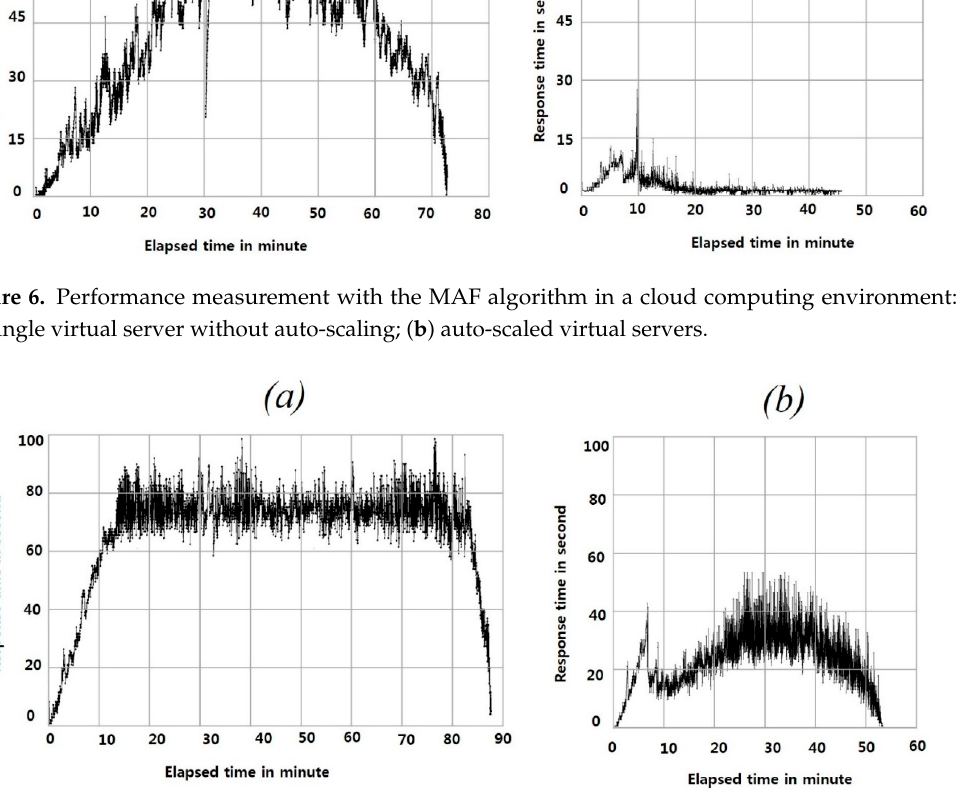
Figure 7. Performance measurement with the NDVI algorithm in a cloud computing environment: ( a ) single virtual server without auto-scaling; ( b ) auto-scaled virtual servers.